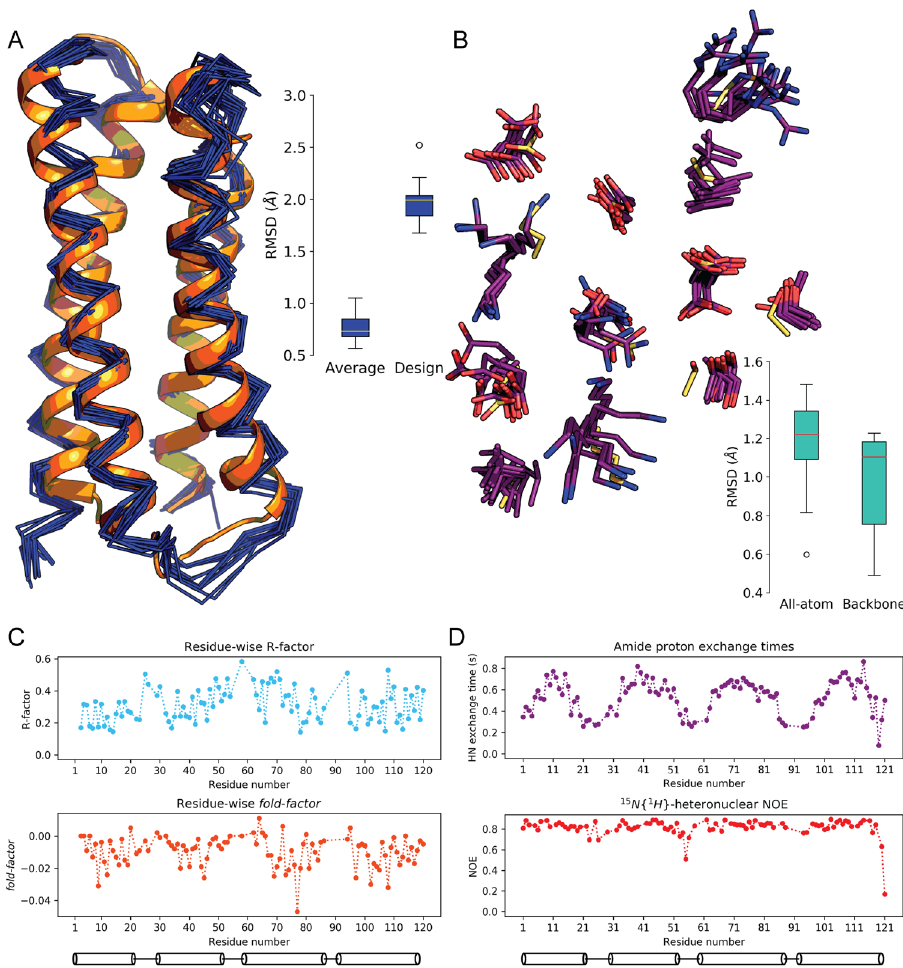
Fig. 4 The design model shows atomic-level agreement with its NMR solution structure. A Boskar4 solution structure shows an ensemble deviation from the average structure of 0.8, and 2.0 Å from the designed coordinates. The design model (orange) is shown against the NMR ensemble (dark blue). The boxplot shows the median and spread across the ensemble frames. B The backbone atoms RMSD of the binding epitope averaged at 1.0 Å, while all-atom RMSD of averaged at 1.2 Å, highlighting the design precision. The design model residues (yellow) are shown against the NMR ensemble (purple), and the box plot shows the deviations across the ensemble. The boxplot shows the median and spread across the ensemble frames. The box plots represent median (central line), 1st and 3rd interquartile range (box), and minimum and maximum of 1.5 times the latter interquartile range (whiskers). C Residue- wise R -factor values for the covered residues are shown (top), indicating the normalised CNH-NOESY RMSD from the expected spectra by the fi nal ensemble. The fold-factor shown (bottom), a metric which signi fi es the R -factor reduction by non-local residue-residue contacts, shows the contribution of buried helical residues to Boskar4 folding. D Both amide proton exchange (top) and 15 N { 1 H }NOEs (bottom) show the backbone amides of the helical residues to be solvent-shielded and conformationally rigid,